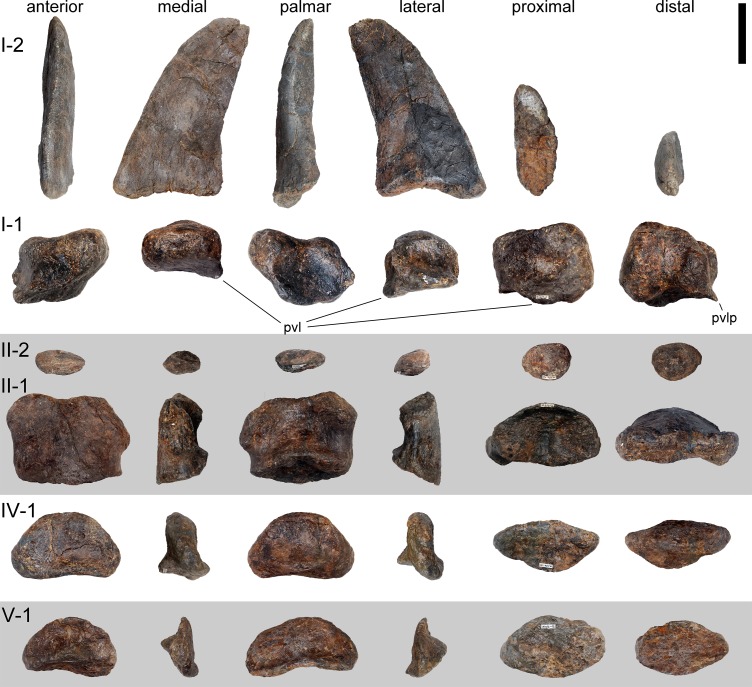
Left manual phalanges of Galeamopus pabsti SMA 0011.The phalanges are shown in anterior, medial, palmar, lateral, proximal, and distal view. Digits are indicated on the left with roman numbers. Abb.: pvl, posteroventral lip; pvlp, posterior ventrolateral process. Scale bar = 5 cm.